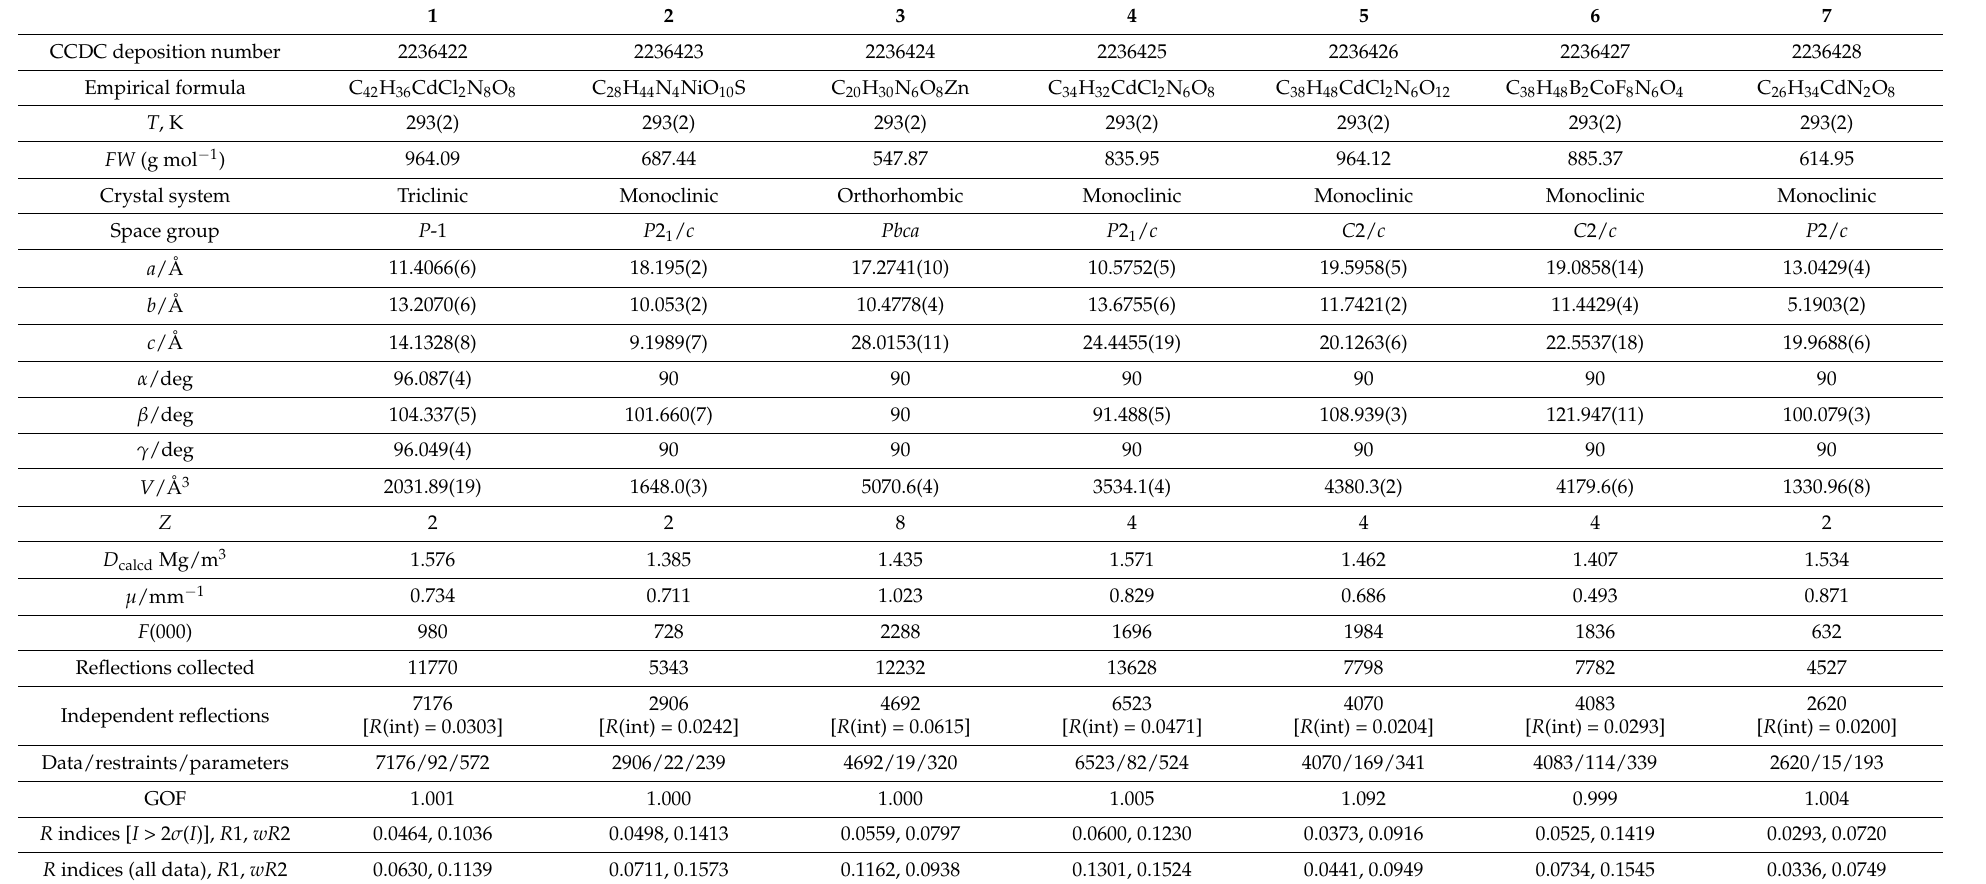
Table 1. Crystal data and structure refinement parameters for 1 – 7